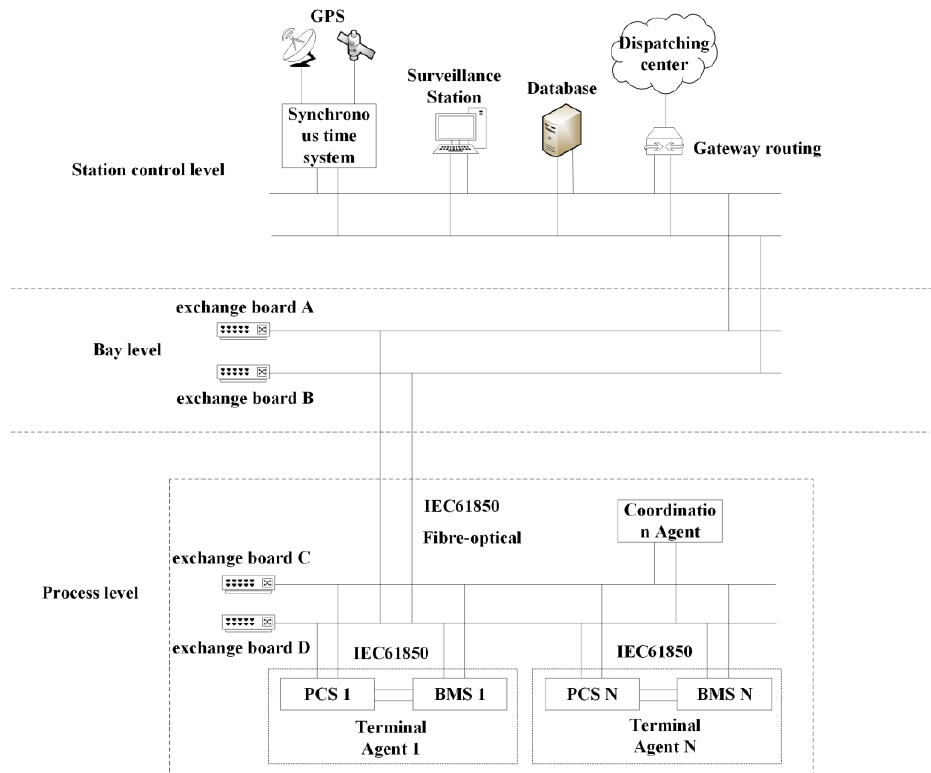
Figure 9. Communication architecture.